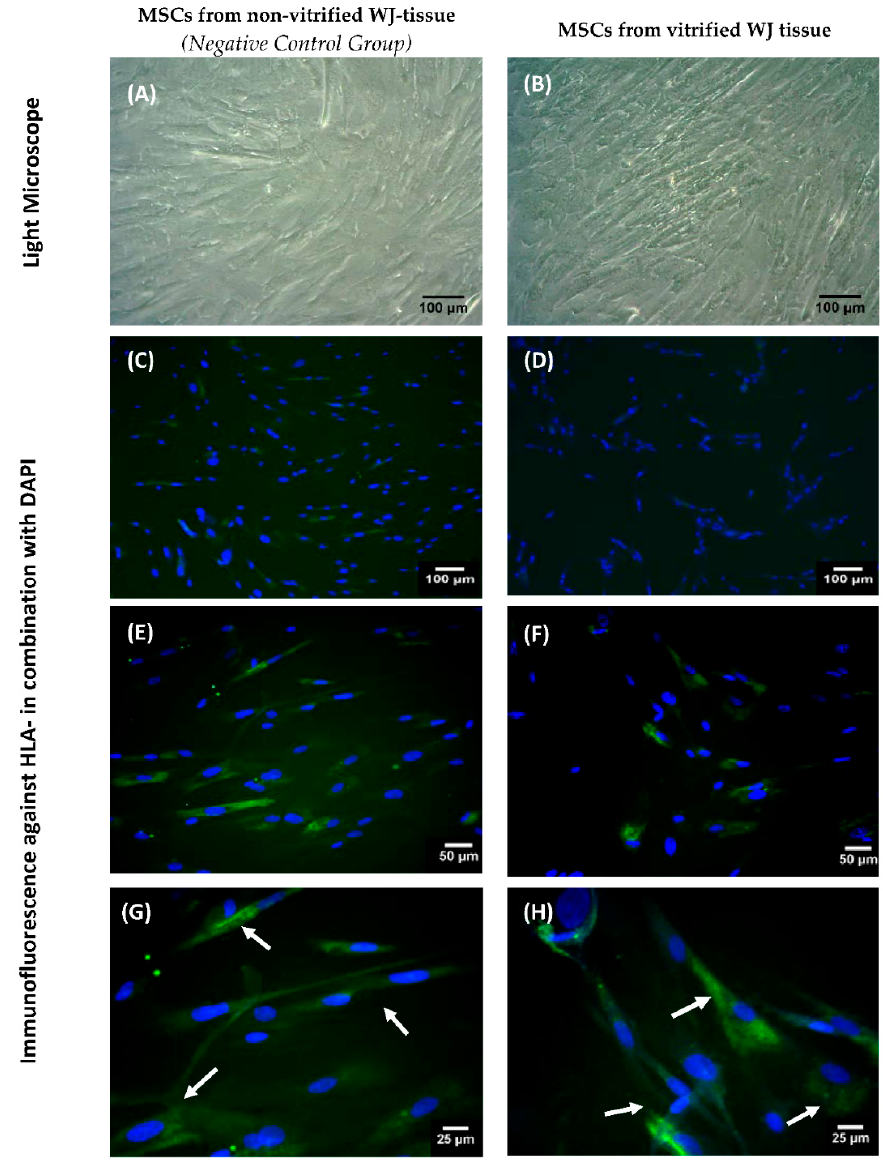
Figure 6. HLA-G expression in WJ-MSCs. WJ-MSCs obtained from non-vitrified (n = 5) and vitrified (n = 5) WJ tissue with light microscopy ( A , B ). Indirect immunofluorescence against HLA-G in combination with DAPI in MSCs derived from non-vitrified ( C , E , G ) and vitrified ( D , F , H ) WJ tissue samples. Images A , B were acquired with original magnification 10×, scale bars 100 μ m. Images C , D were acquired with original magnification 10×, scale bars 100 μ m. Images E , F were acquired with original magnification 20×, scale bars 50 μ m. Images G , H were acquired with original magnification 40×, scale bars 25 μ m.